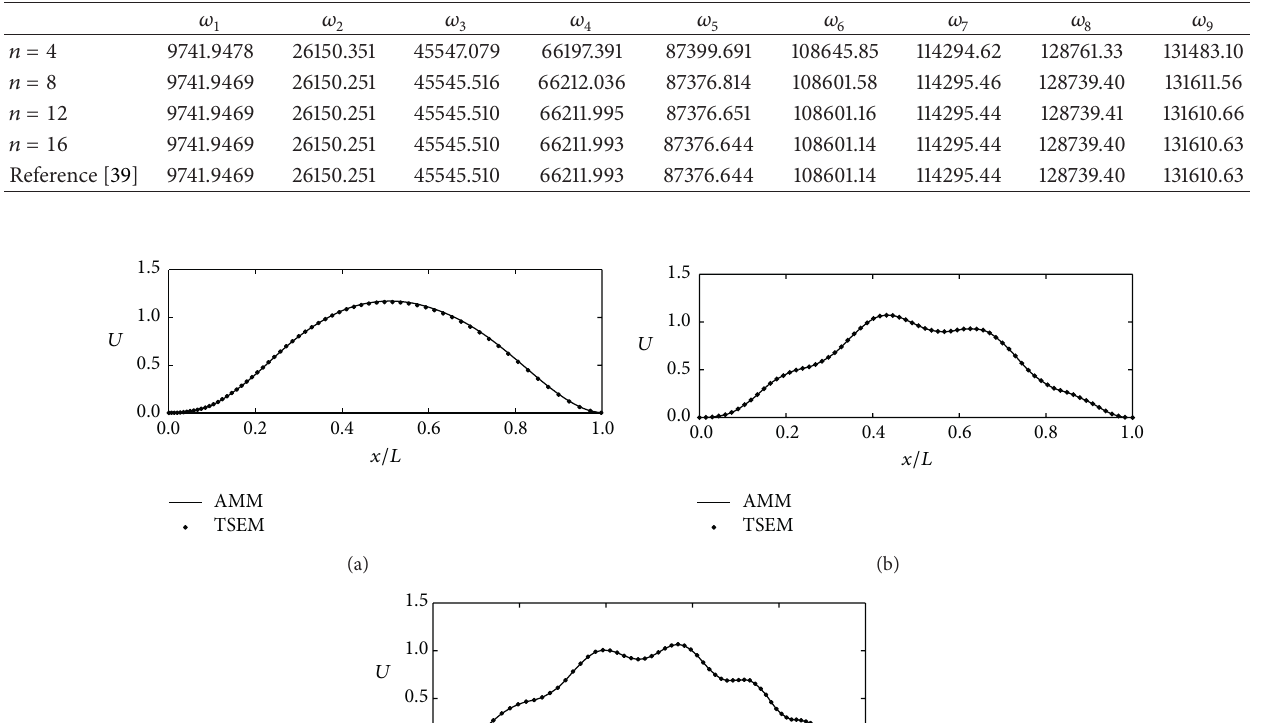
Table 3: Free vibration frequencies for clamped-simple Timoshenko beam.